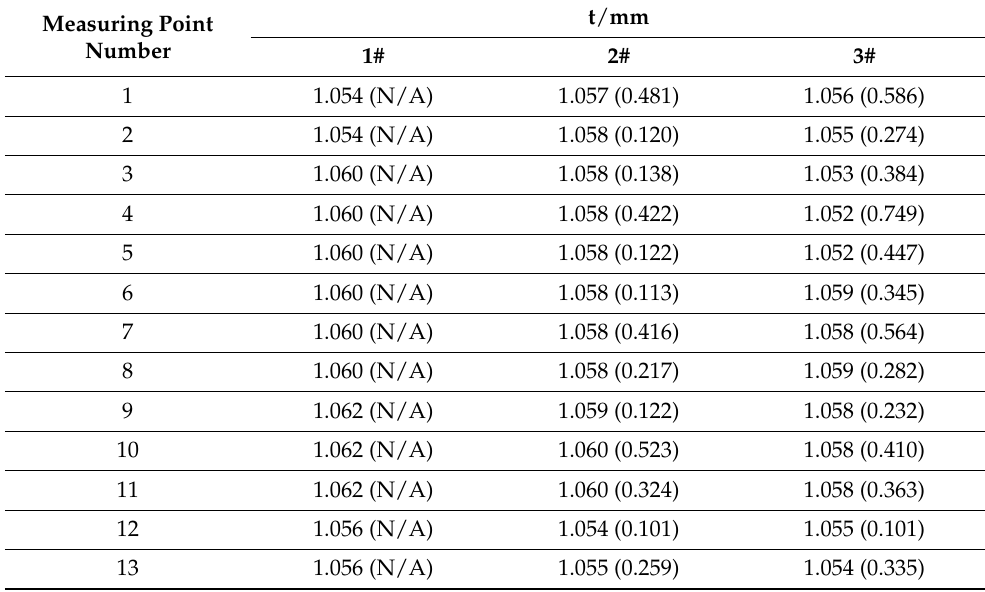
Table 4. Measured wall thicknesses of three preformed toroids. Measuring